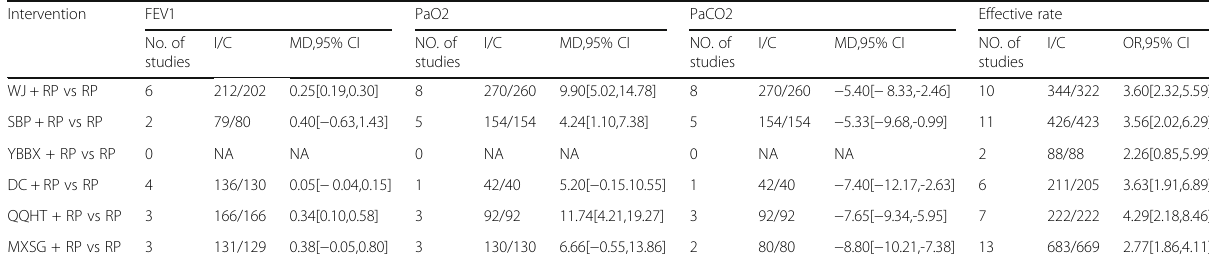
Table 2 Pair-wised random-effects meta-analyses Intervention FEV1 PaO2 PaCO2 Effective rate No. of I/C MD,95% CI NO. of studies studies